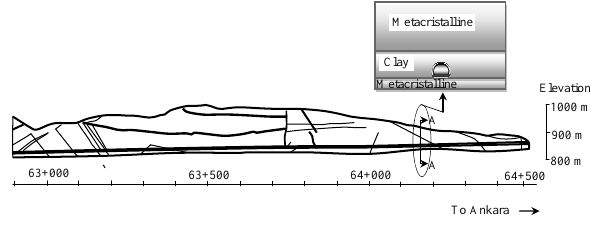
Fig.1. Bolu Tunnel-longitudinal profile (Amberk and Russo, 2001) Fig. 1. Bolu Tunnel-longitudinal profile (Amberk and Russo, 2001). Table 1. Material properties for A-A cross section of the Bolu Tunnel. Table 1. Material properties for A-A cross section of the Bolu Tun- nel.